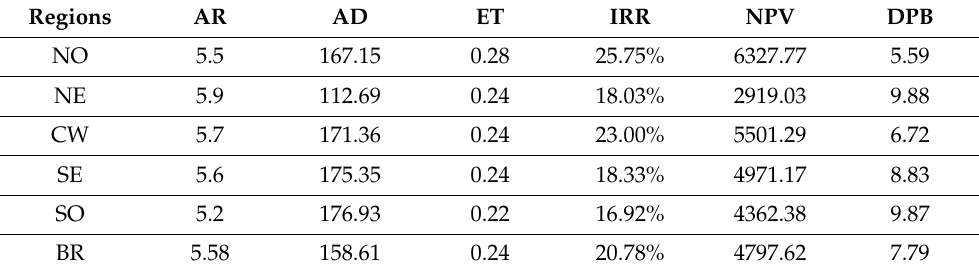
Table 1. Deterministic results before the change proposed by ANEEL.